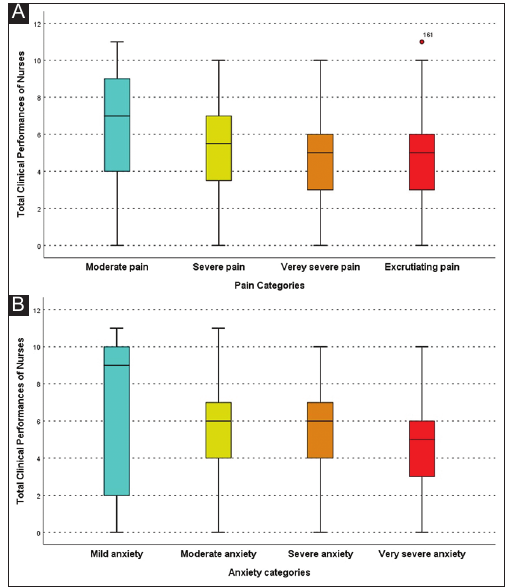
FIGURE 1. Comparisons of clinical performances of nurses in patients with different pain levels (A) and different anxiety levels